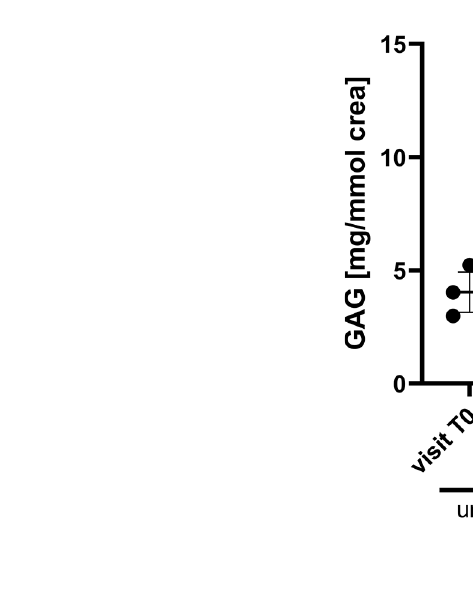
FIGURE 4 | Urinary GAG content in patients with GVUS and FD patients after ERT or migalastat treatment. crea, urinary Creatinine; ERT, enzyme replacement therapy; GAG, glycosaminoglycans; GVUS, genetic variant of unknown signi fi cance. Analyzed by One-Way ANOVA. T0, fi rst; treatment-naïve visit (retrospective); T2, last/current